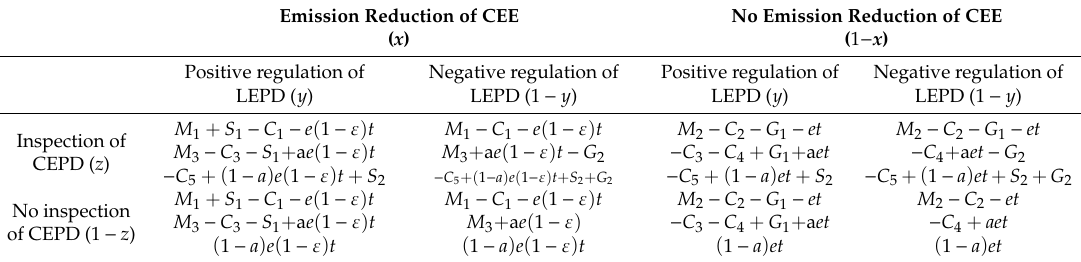
Table 2. Behavioral strategy portfolios of CEE, LEPD, and CEPD and their revenue matrix. Emission Reduction of CEE ( x )